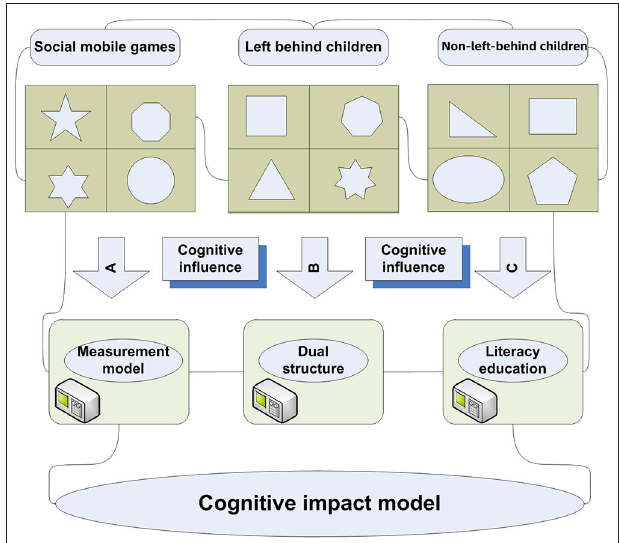
FIGURE 1 | Schematic diagram of the cognitive measurement model of left-behind